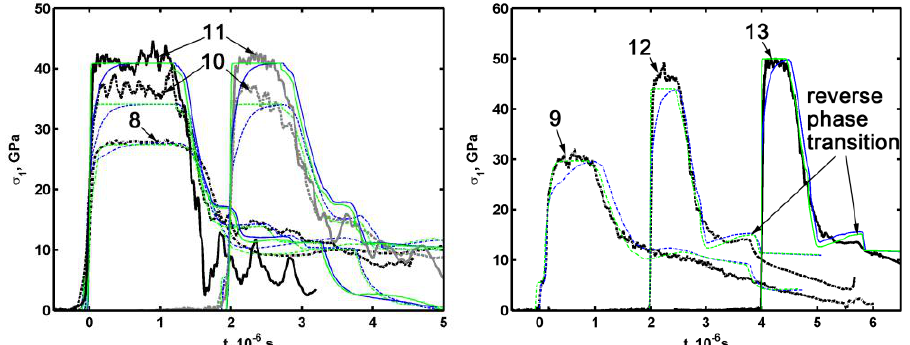
Fig. 4. Experimental stress profiles from manganin gauge measurements in comparison with calculations with different descriptions of α -qurtz–stishovite transition kinetics. The right figure shows profiles measured in one test at distances 4 and 8 mm from the loading surface; the left is for a sample thickness of 6 mm before the gauge. The time interval between the profiles is artificially increased for convenience: the profiles are shown at a step of 2 μ s beginning from the time of shock arrival. Experimental profiles are shown by black and gray lines . Calculated profiles are shown in blue and green for different models of phase transition